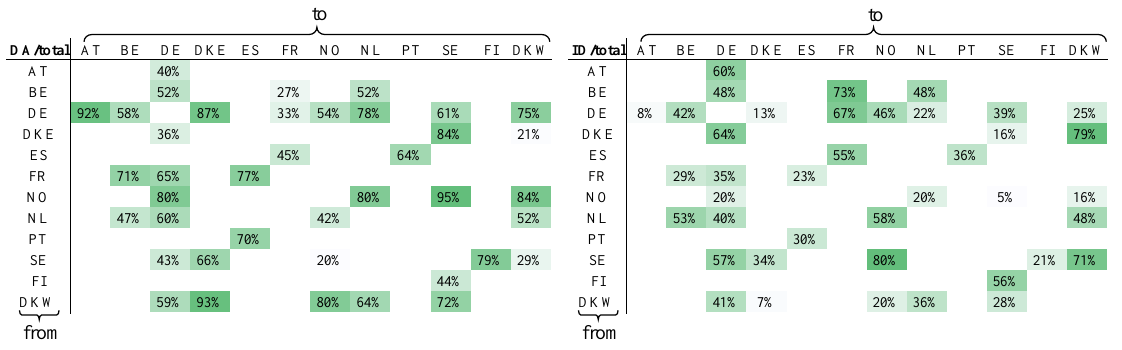
Figure 15. CB trading volumes in relation to the total trading volume for 2023.